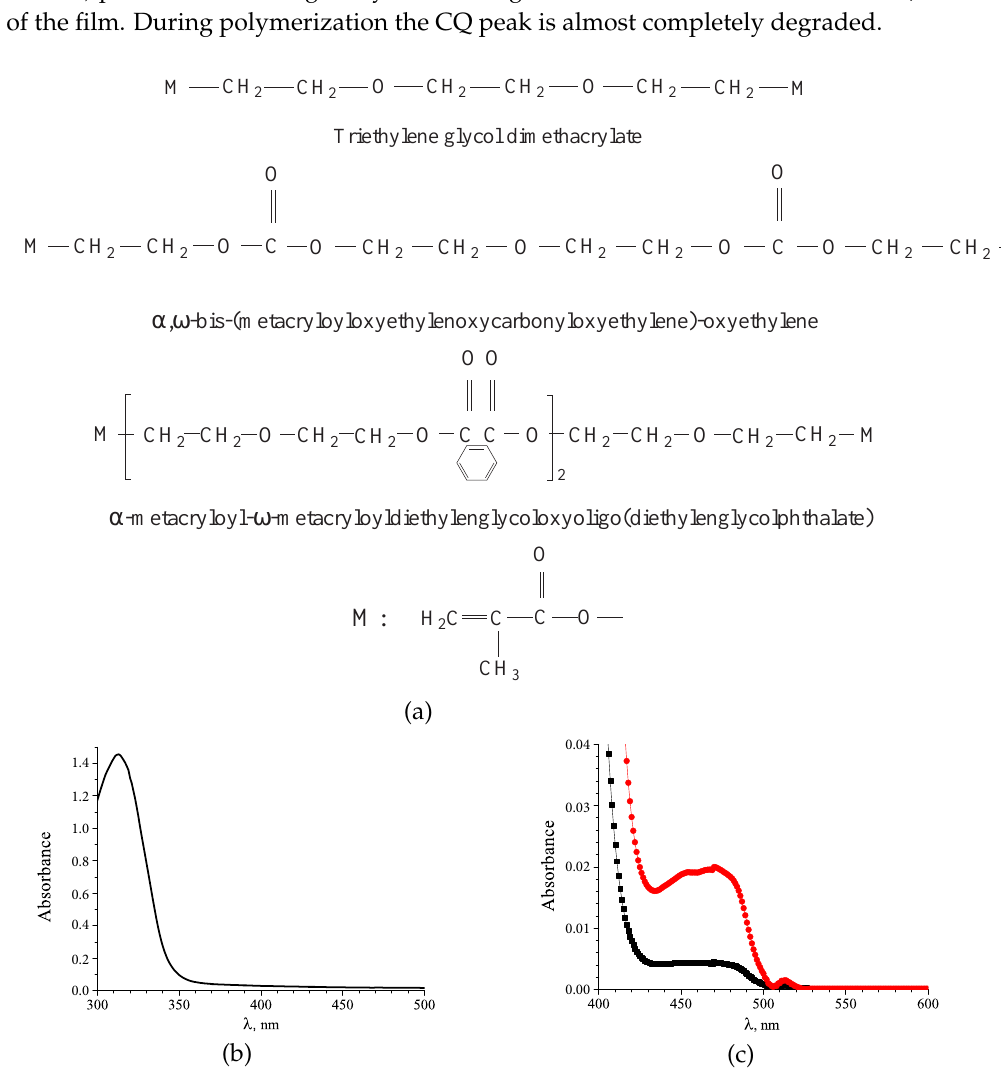
Figure 7. Chemical structure of the mixture components ( a ). Absorption spectra of a solution of AgNO 3 in acetonitrile ( b ), and mixture before (red) and after (black) polymerization ( c